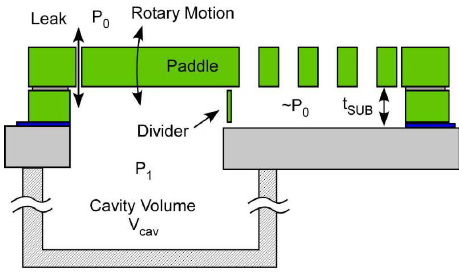
the weak energy in the sound pressure, acoustic switches are rarely reported. A zero-